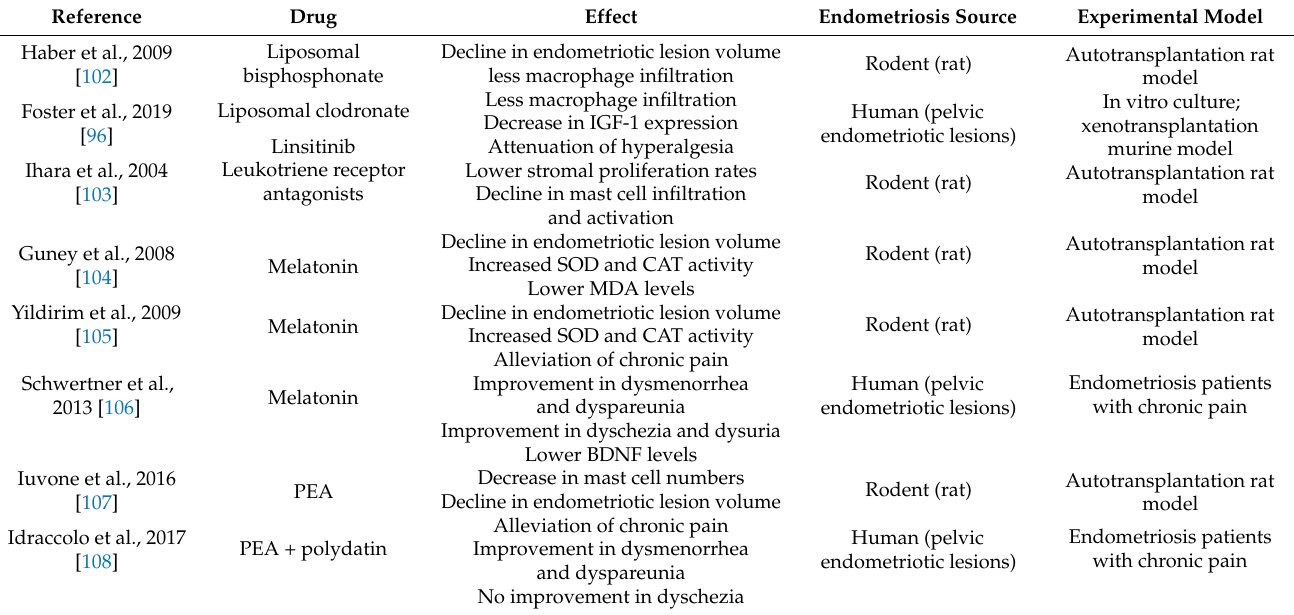
Table 2. Drugs decreasing macrophage and mast cell infiltration and